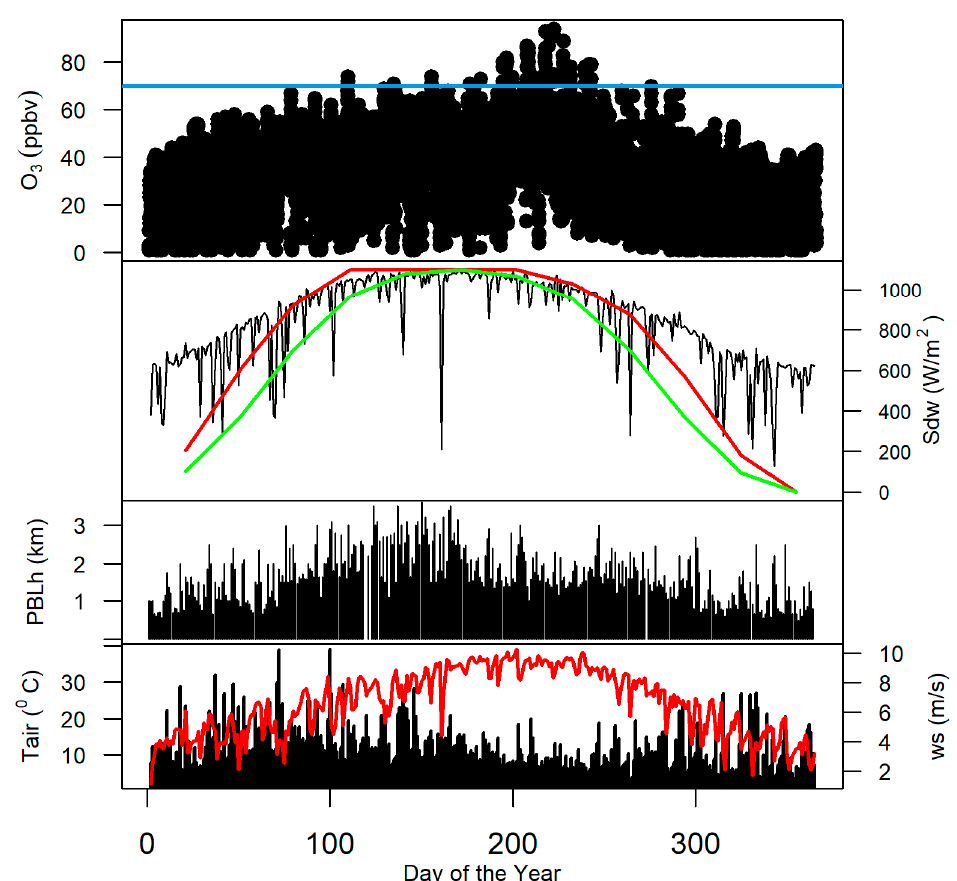
Figure 4. Daily hourly ozone concentration in ppbv (top, 1); downward solar radiation (Sdw), photolysis frequencies of NO 2 (red) and O 3 (green) (2), maximum daily CBLH in (m) (3), and afternoon average wind speeds in black (between 13–17 pm) and daily maximum air temperature in red (bottom, 4) for the year 2019. The blue line at the top marks the 71 ppbv of ozone level.